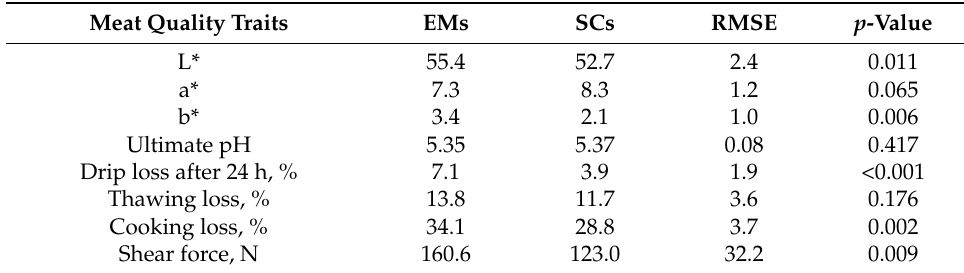
Table 3. Meat quality traits of the longissimus dorsi, pars lumborum muscle according to sex group. Meat Quality